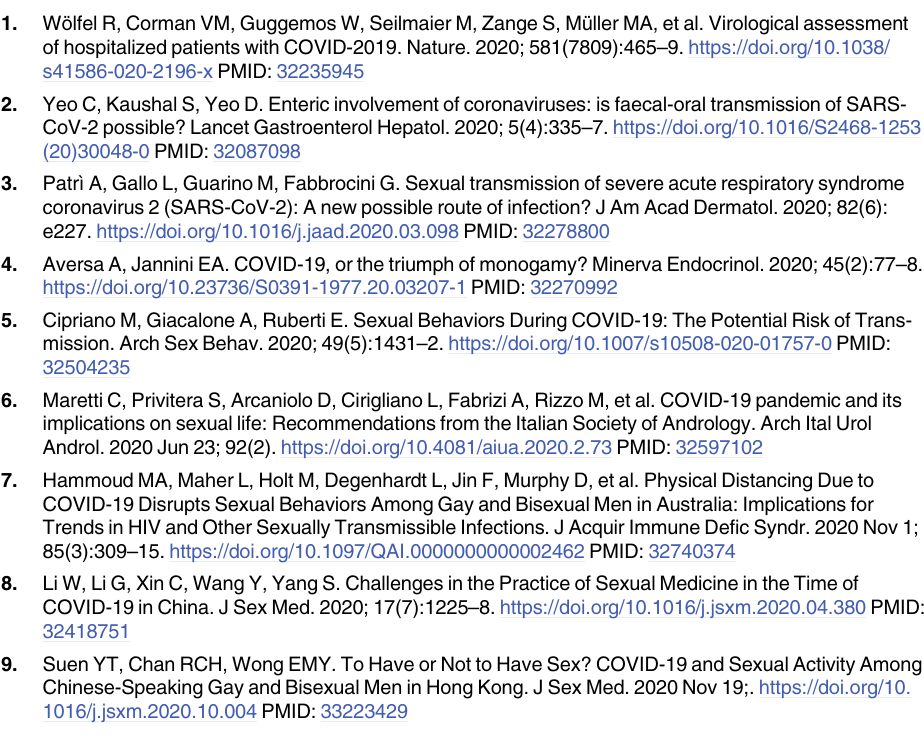
S1 Fig. Scatter plots showing correlation between Pornhub traffic and new daily average Covid19 cases. Traffic of Pornhub, percentage change compared to average day before